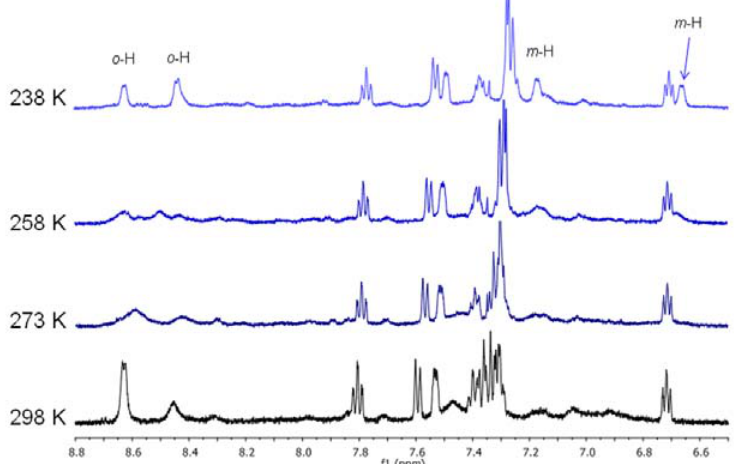
Figure 4. 1 H - NMR spectra of 1c , in CD meta protons of 4-picoline are